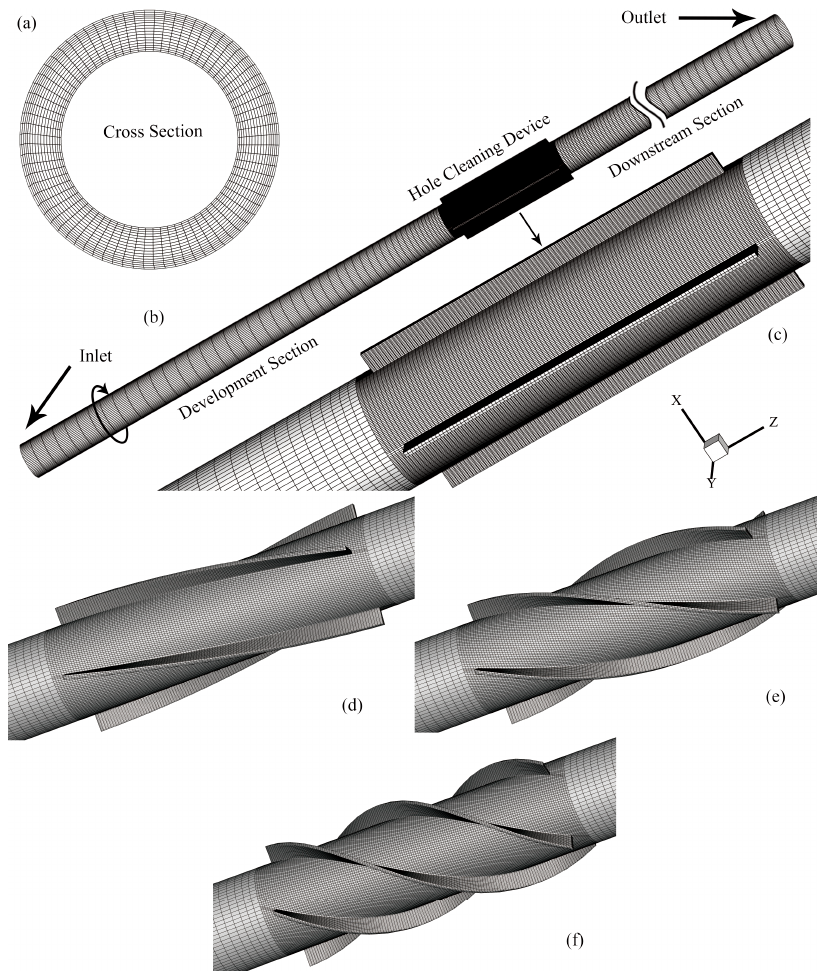
Figure 1. 3D view of the computational domain including hole cleaning device: ( a ) cross ‐ sectional view; ( b ) entire grid system; ( c ) α = 0°; ( d ) α = 10°; ( e ) α = 20°; ( f ) α = 30°. view; ( b ) entire grid system; ( c ) α = 0 ◦ ; ( d ) α = 10 ◦ ; ( e ) α = 20 ◦ ; ( f ) α = 30 ◦ .